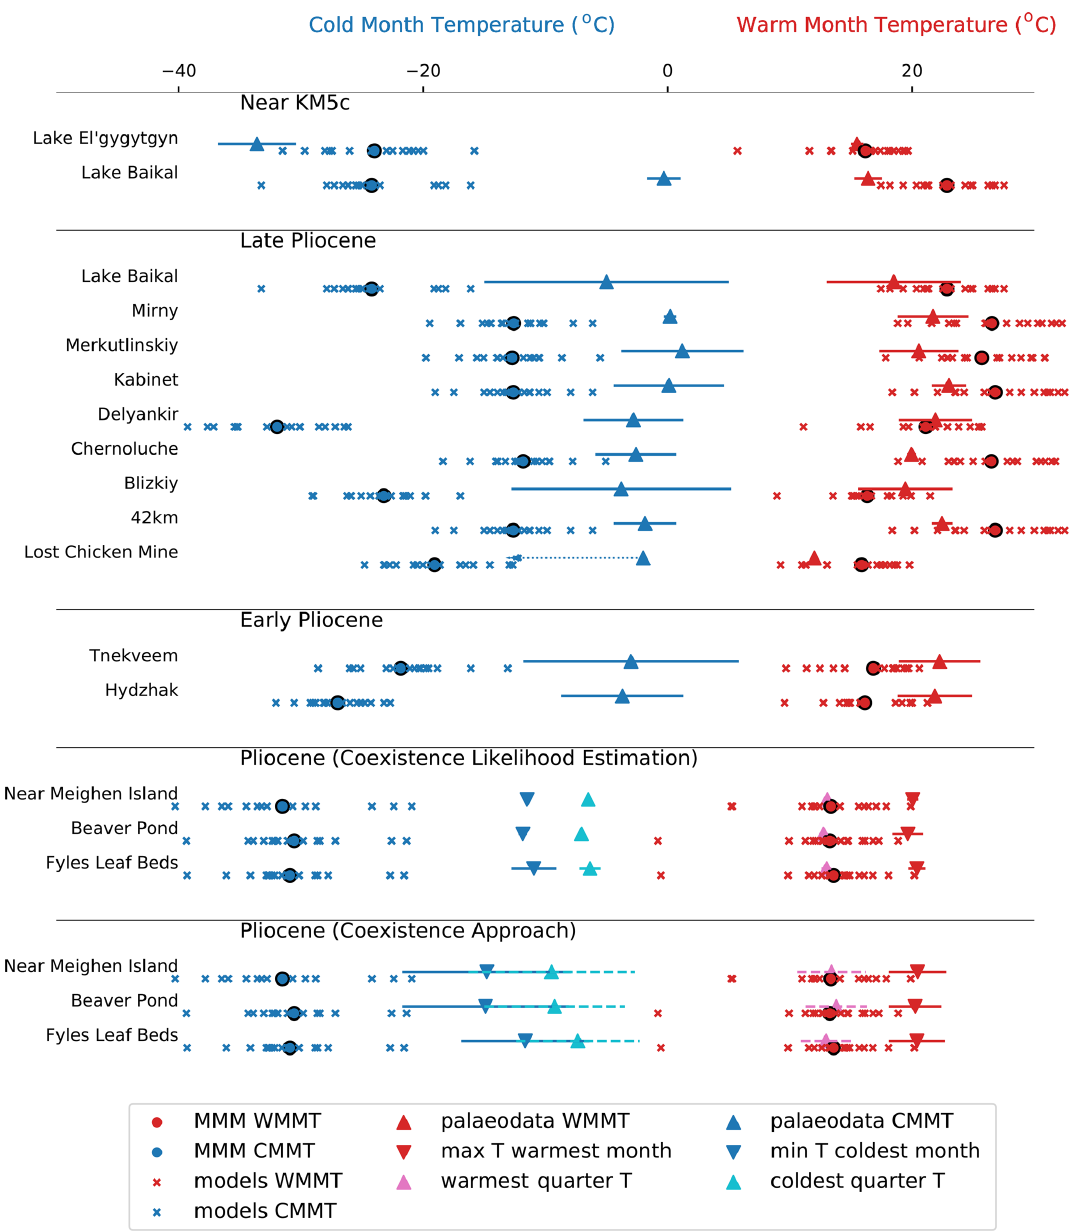
Figure 3. Data–model comparison for the cold month mean temperature (CMMT; blue) and the warm month mean temperature (WMMT; red). Triangles show temperatures from proxy data with published uncertainties (where available). The Pliocene CMMT at Lost Chicken Mine was reported as “less than − 2 ◦ C but not nearly as cold as the modern”, and this is represented by the dotted line and arrow. The location of Meighen Island (80 ◦ N, 99 ◦ W) was an oceanic grid box in most models, and hence Meighen Island data have been compared to a nearby land grid box. Model data are WMMT or CMMT and are shown by circles (MMM) or small crosses (individual models). Additional metadata are in Table